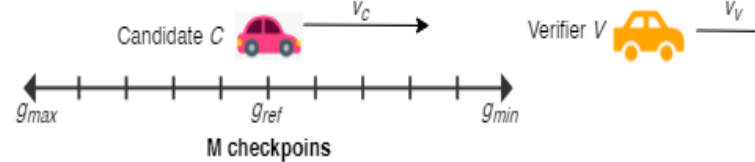
Figure 5. Setting a range for candidate C’s checkpoint.